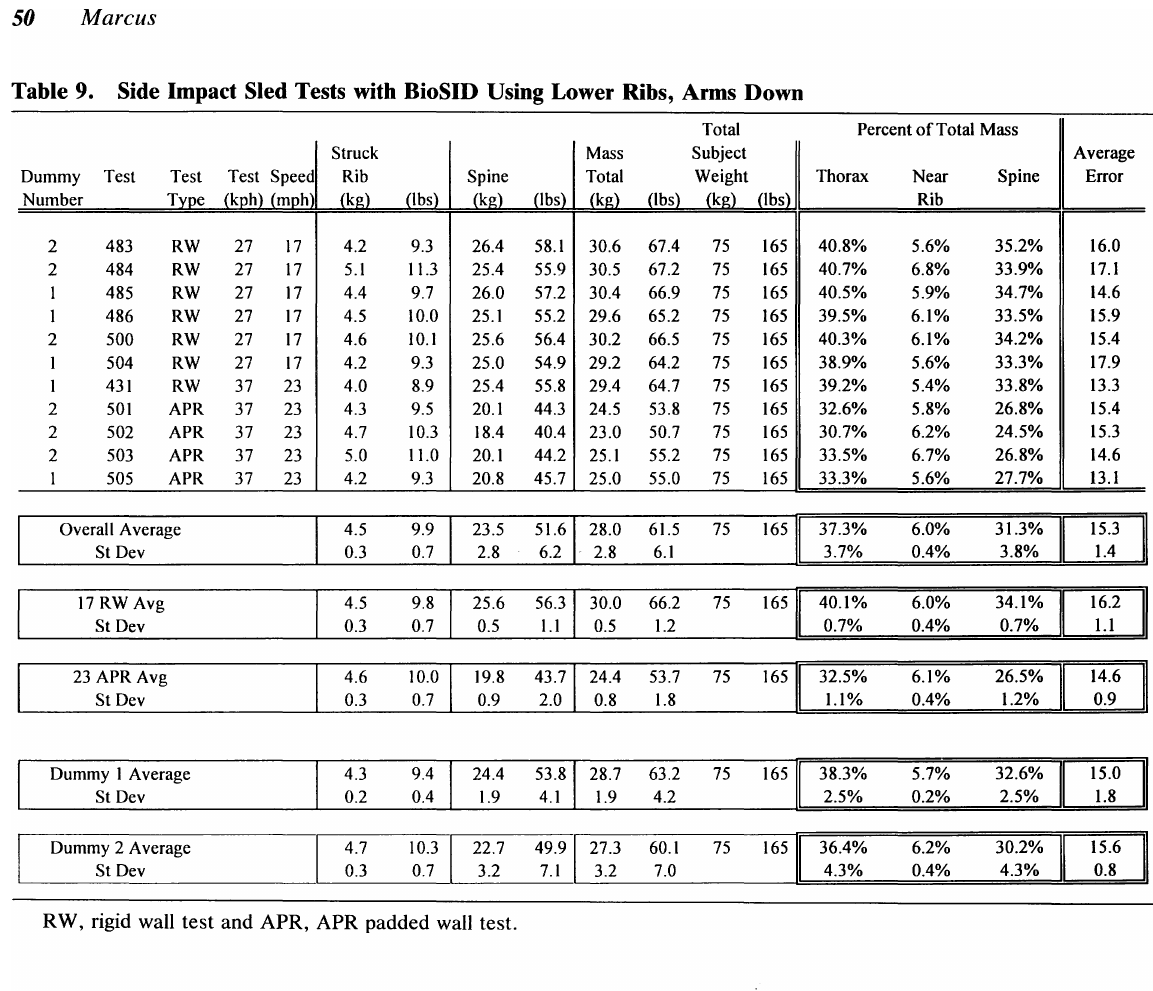
Overall Average St